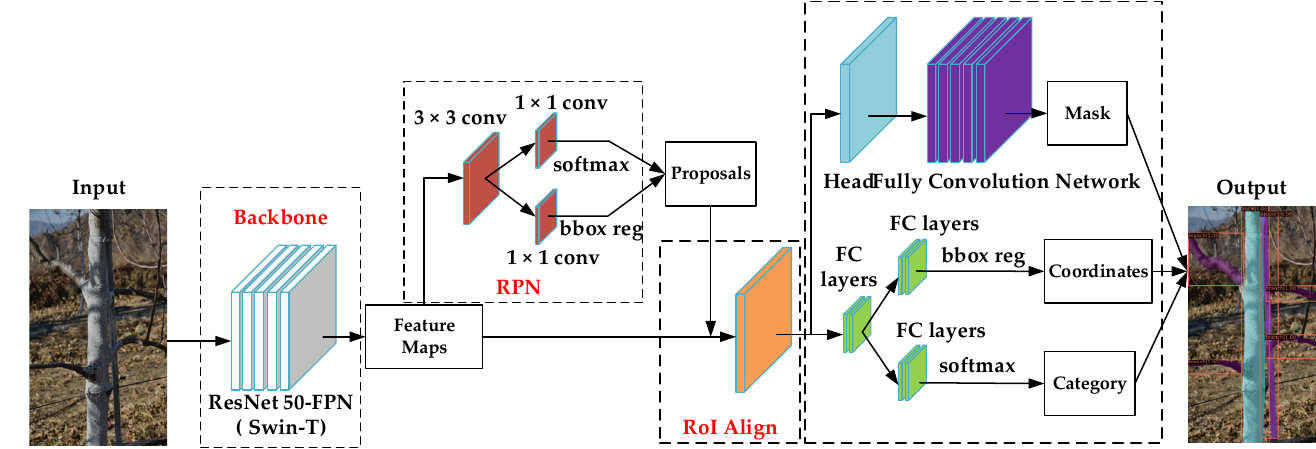
Figure 2. Frame diagram of apple tree segmentation based on Mask R-CNN.